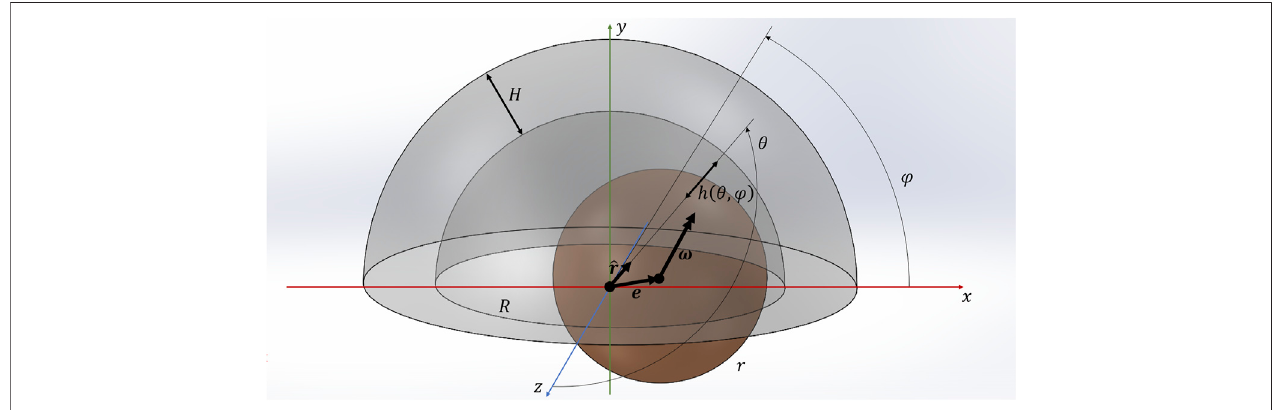
FIGURE 2 | Ball in socket lubrication system